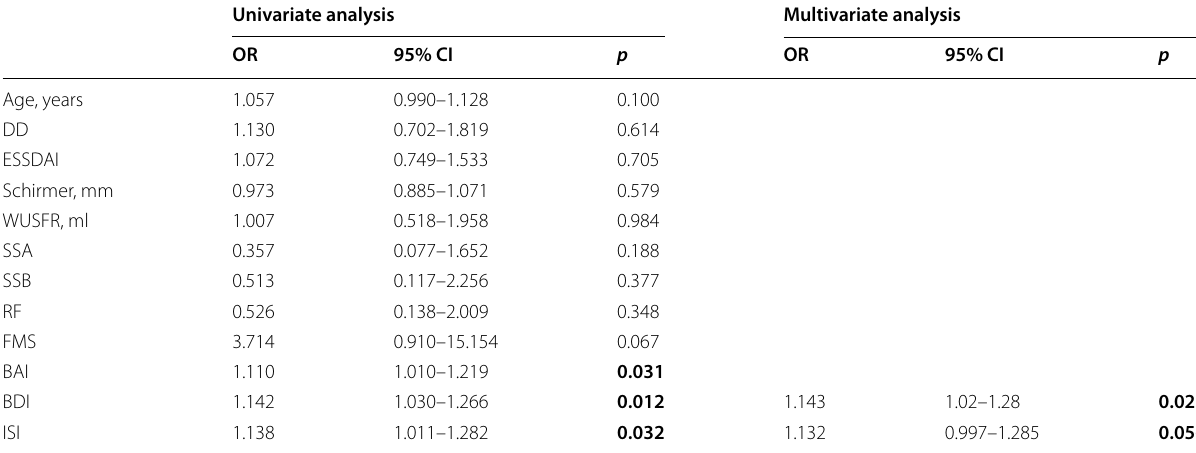
Table 4 Regression